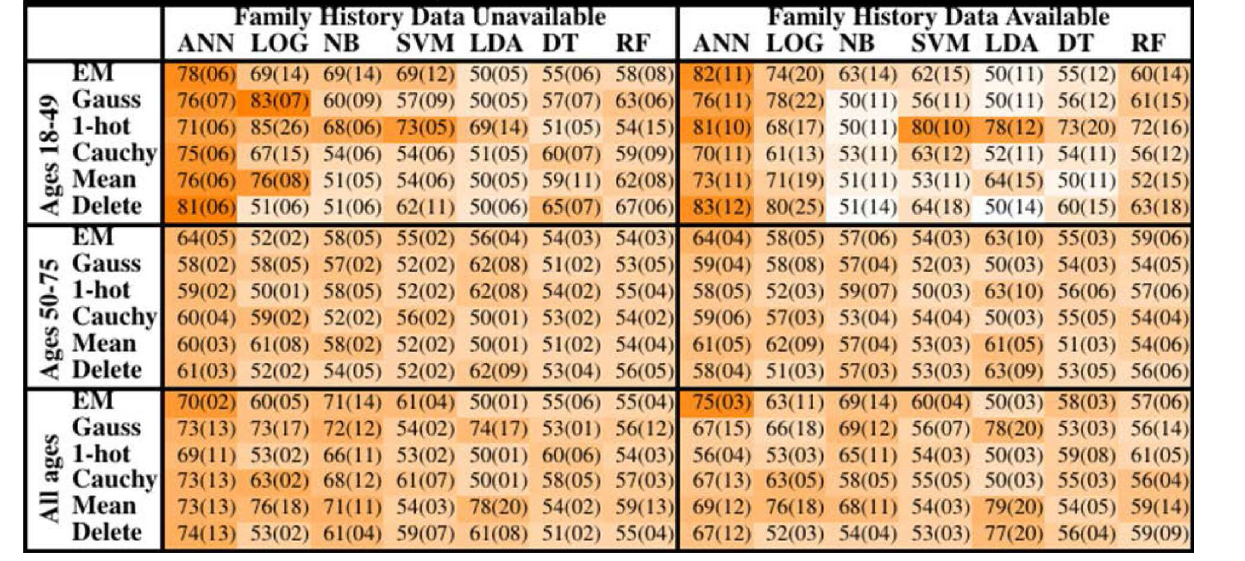
TABLE 1 | Mean concordance (standard deviation), multiplied by 100, for various machine learning algorithms, imputation methods, age groups, and with or without family history of CRC